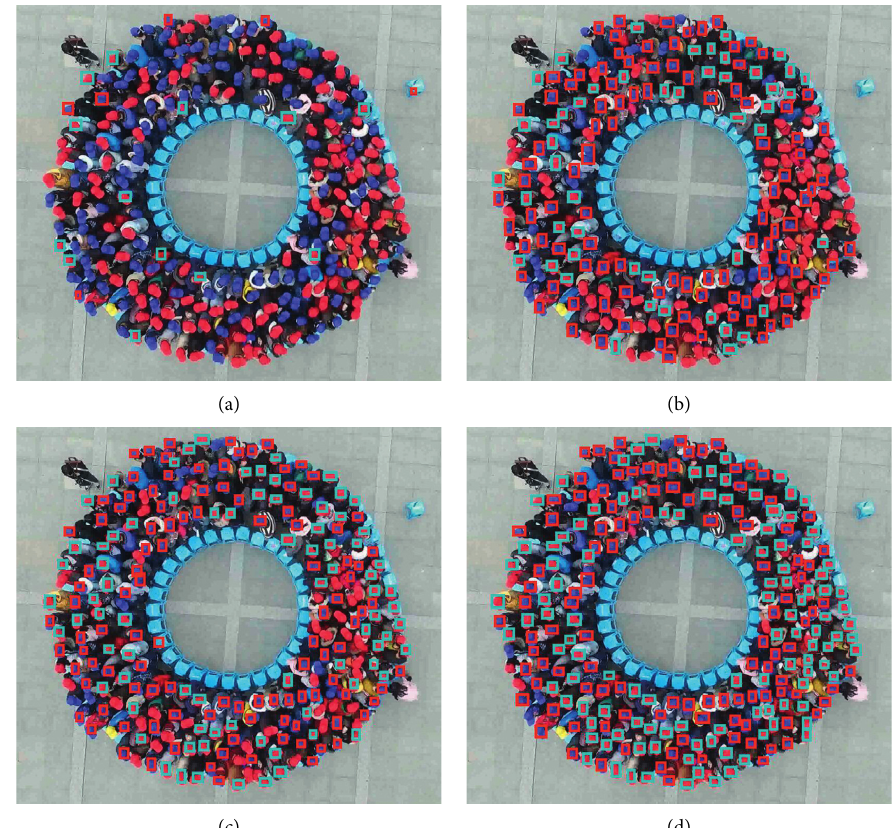
Figure 5: The detection results of Figure 3(d) with different training sets. (a) T1; (b) T2; (c) T3; (d) T4. The scores of each object are not presented, since they could mask the positions of other pedestrians.